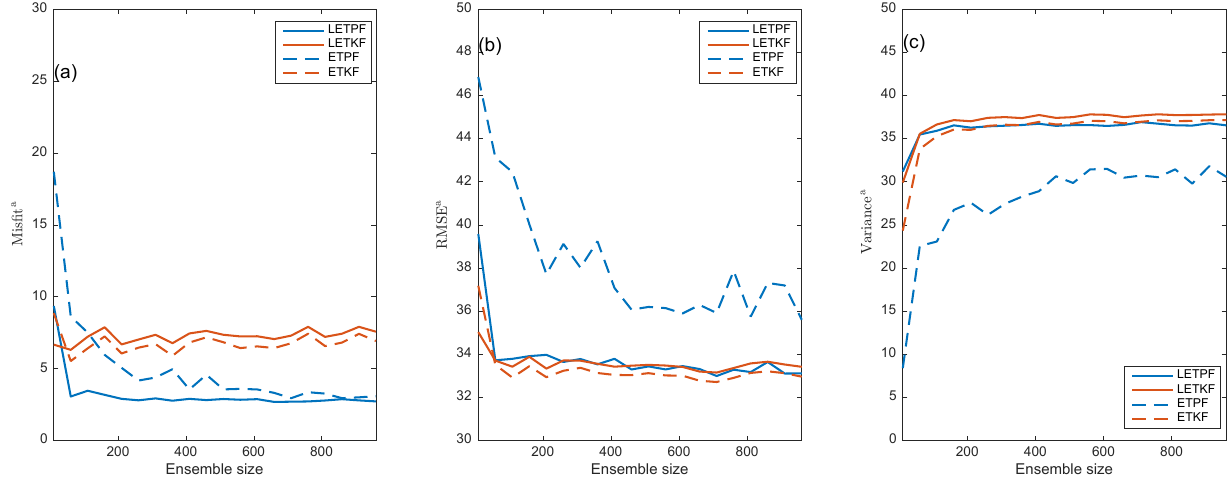
Figure 14. Mean over 10 simulations after data assimilation for the data misfit (a) , RMSE (b) , and variance (c) . LETPF is shown in solid blue and LETKF in solid red. ETPF is shown in dashed blue and ETKF in dashed red.